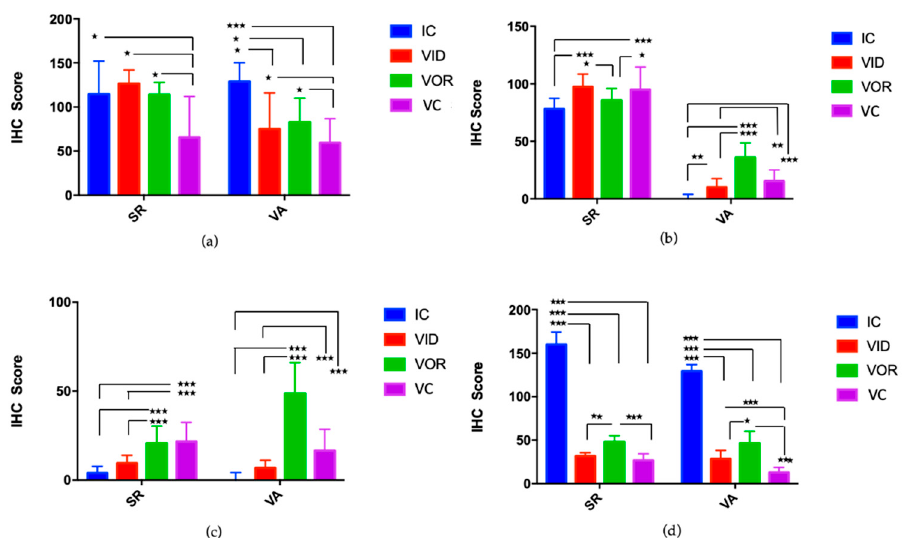
Figure 4. Macrophage polarization status. Mean immunohistochemistry score (IHC-score) in sacculus rotundus (SR) and vermiform appendix (VA) in the infected controls (IC), experimental intradermal vaccine (VID), experimental oral vaccine (VOR), and control vaccine (VC) animals for ( a ) IFN γ ; ( b ) TNF α ; ( c ) CD163; ( d ) calprotectin. Error bars represent the Confidence Interval of 95%. * p < 0.05; ** p < 0.01; *** p < 0.001.